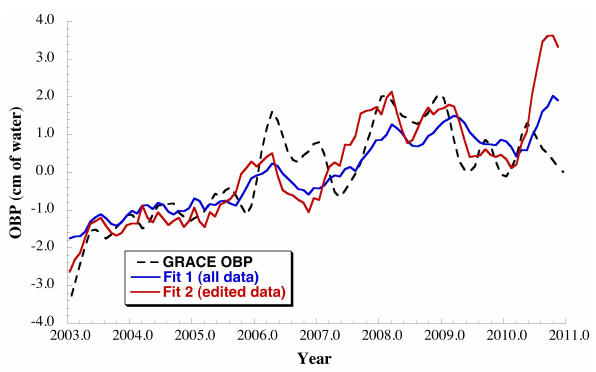
Fig. 8. Time-series of low-pass filtered GRACE OBP as well as two different fits based on parameterizing the ENSO variability. See text (Eq. 2) for a discussion of the model and fits.